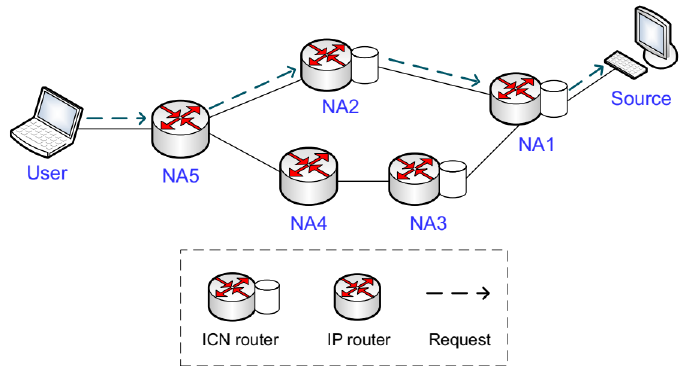
Figure 1. An example of content retrieval in ICN.